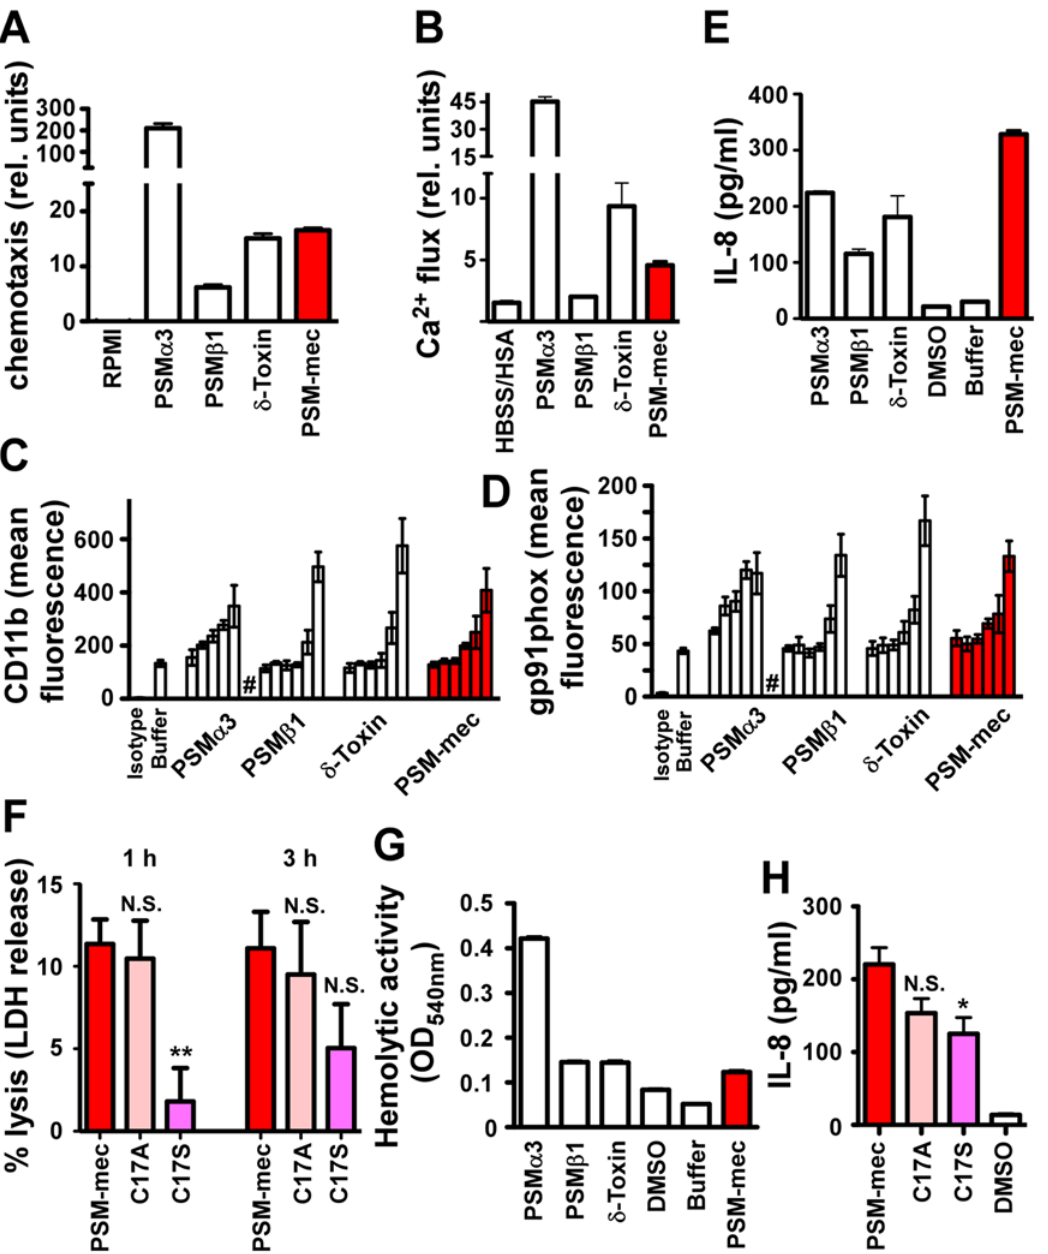
Figure 6. Pro-inflammatory and cytolytic capacities of PSM-mec and derivatives. (A) Chemotaxis of human neutrophils. Peptides were applied at 0.5 m g/ml (PSM a 3), 2 m g/ml ( d -toxin), 5 m g/ml (PSM-mec), and 10 m g/ml (PSM b 1). (B) Calcium flux in human neutrophils. Peptides were applied at 0.1 m g/ml (PSM a 3), 1 m g/ml ( d -toxin, PSM-mec), and 2.5 m g/ml (PSM b 1). In (A) and (B), values were corrected for the different concentrations applied. (C,D) Surface expression of CD11b and gp91 phox on human neutrophils. # , lysis of neutrophils occurred. For PSMs, bars represent values obtained from increasing concentrations of peptide: 10, 100, 200, 400, 1000, 10000 ng/ml, from left to right in each group. (E) Secretion of the cytokine IL-8 at 10 m g/ml of PSM. (F) Neutrophil lysis at 50 m g/ml of PSM, comparison of PSM-mec with C17A and C17S replacement peptides. (G) Hemolytic activity. (H) Secretion of IL-8, comparison of PSM-mec with with C17A and C17S replacement peptides. (G,H) PSM peptides were applied at 10 m g/ml. (F,H) Statistical comparisons are vs. PSM-mec. *, p , 0.05; **,p , 0.01; N.S., not significant. In (A,B,C,D,E, and G) values for PSMs other than PSM-mec and controls that are shown for comparison are from Wang et al. [7]. Values for all samples including PSM-mec were obtained in parallel. strain pairs (Figure 9C). These results indicate that PSM-mec production can substitute for the lack of cytolytic capacity in strains such as MSA890, in which expression of genome-encoded cytolytic PSMs is low. Notably, this includes lysis of human neutrophils as likely the most crucial function of PSMs in pathogenesis.